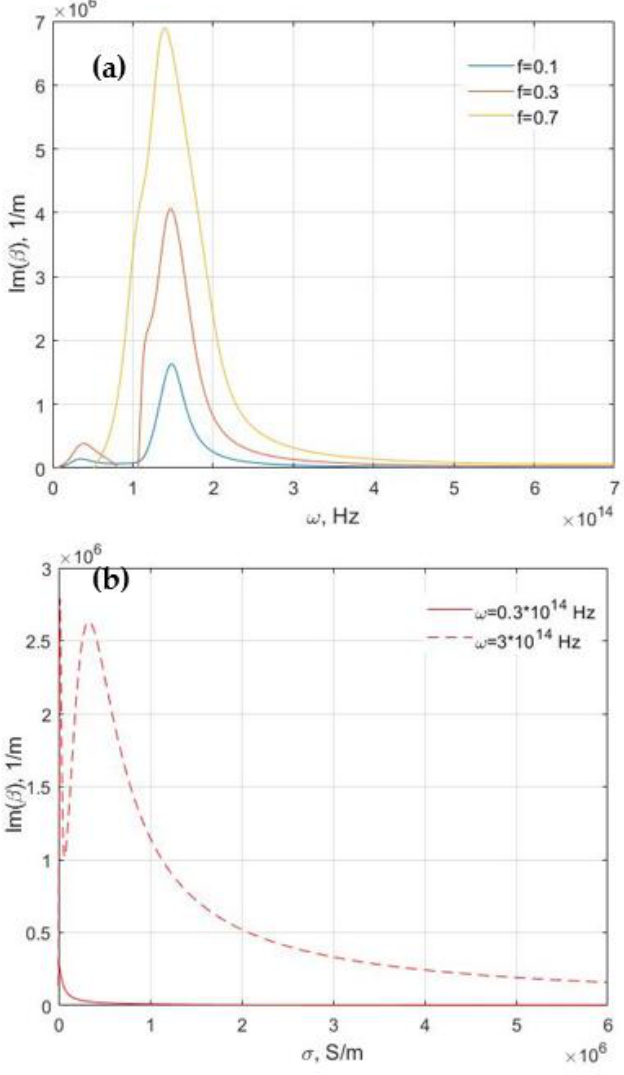
Figure 7. Dependence of imaginary part of propagation constant versus frequency for different filling factors ( a ) and versus conductivity for f = 0.3 ( b ). ε n = 2.25, ε d = 11.8. All the presented results are obtained for the ITO inclusions.